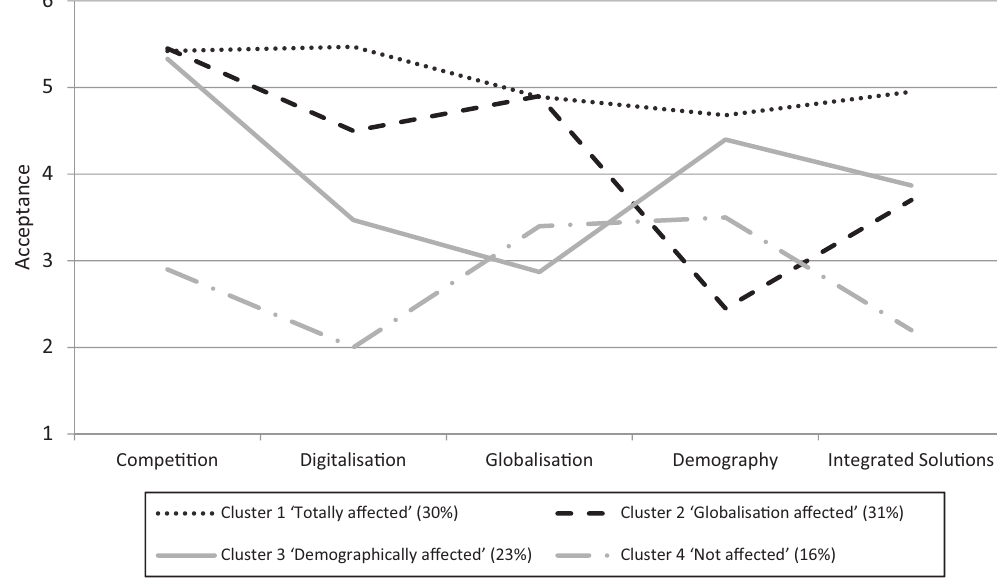
Figure 4. Affected situations of corporate real estate management in structural change as a cluster